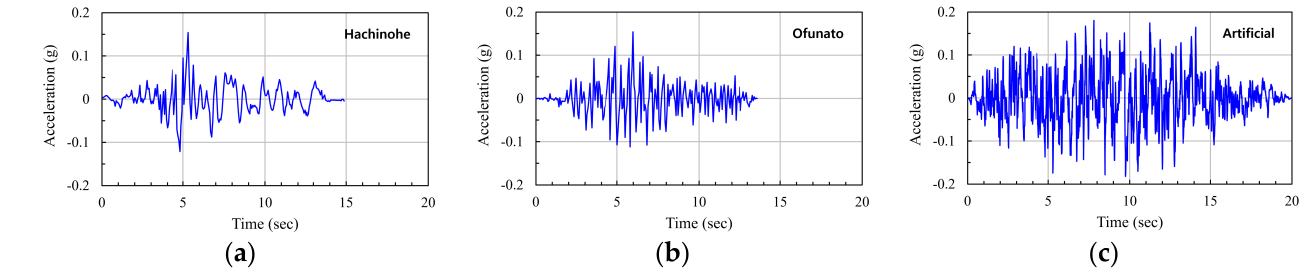
Figure 5. Input seismic waves used in FE analysis. ( a ) Hachinohe wave; ( b ) Ofunato wave; ( c ) artificial wave.